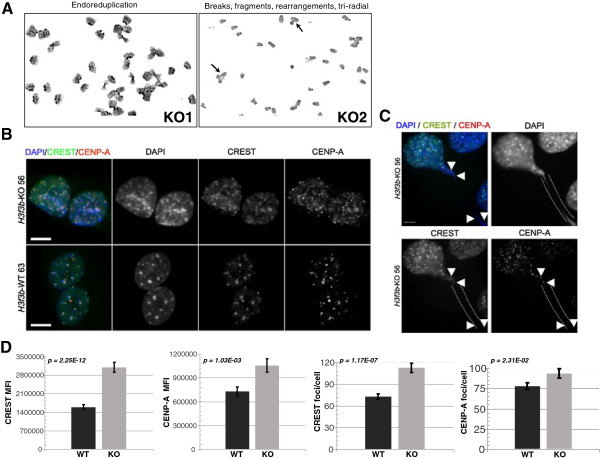
H3f3bknockout(KO) mouse embryonic fibroblasts (MEFs) exhibit chromosomal bridges, severe karyotypic abnormalities, and ectopic staining of CENP-A and CREST. (A) Karyotyping revealed a number of types of abnormalities in H3f3b KO MEFs not observed in wildtype (WT) MEFs including endoreduplication, chromosomal fragmentation, and tri-radial chromosomes (See also Additional file 3: Figure S3 and Table 1). (B) Staining of WT 63 and KO 56 cells with CREST and CENP-A antisera (green and red in merge, respectively). (C) KO MEFs with chromosomal bridges had higher levels of CREST and CENPA foci (white arrows). (D) Quantification of foci staining for KO 49 and 52 versus WT 46 and 48. An average of 17 confocal sections per nuclei were analyzed using ImageJ software as in this study [43]. Scale bars = 10 um.